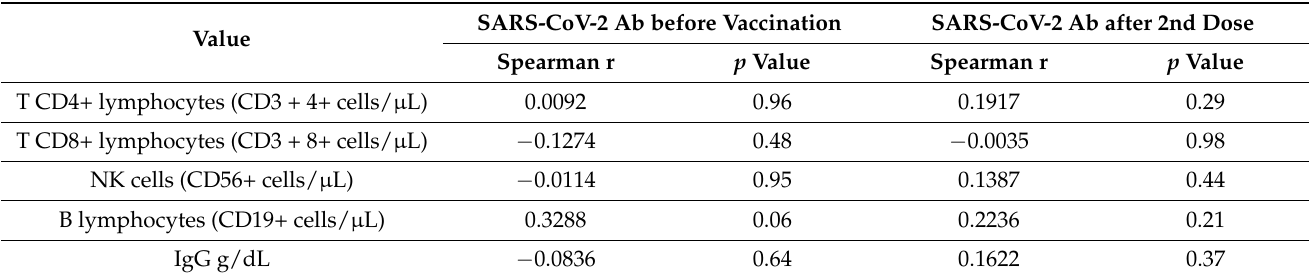
Table 3. Correlation results between lymphocyte subpopulations, IgG concentration, and pre- and post-vaccination anti-SARS-CoV-2 concentration in the HSCT group.